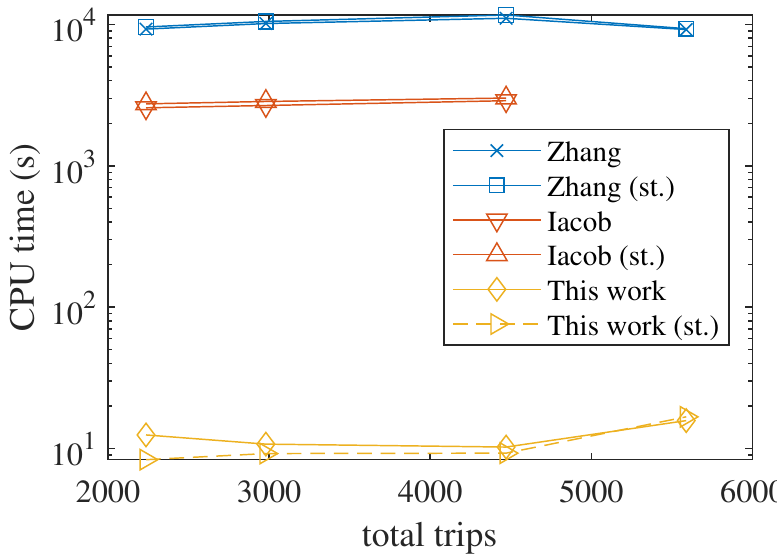
Figure 9. Computational time (log scale) for the benchmark models and the proposed